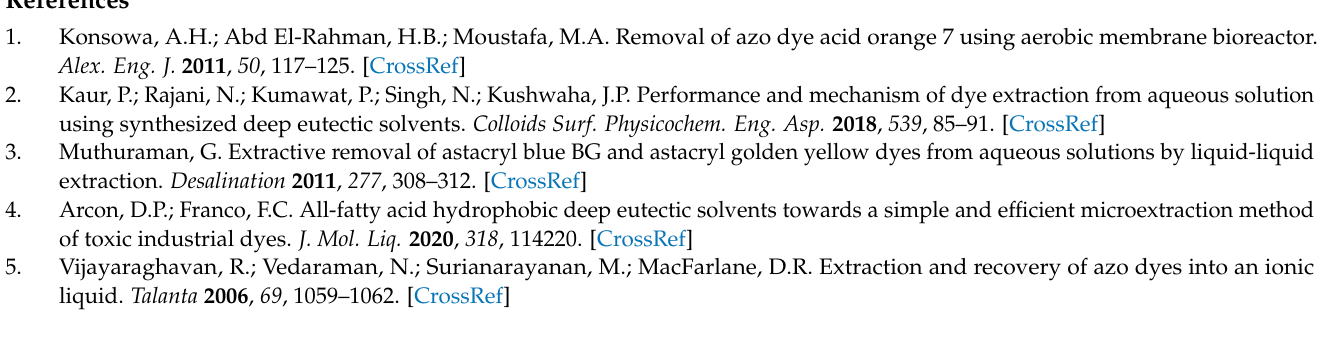
Table S6: Parameters for the adjustement of the kinetic viscosity data to a